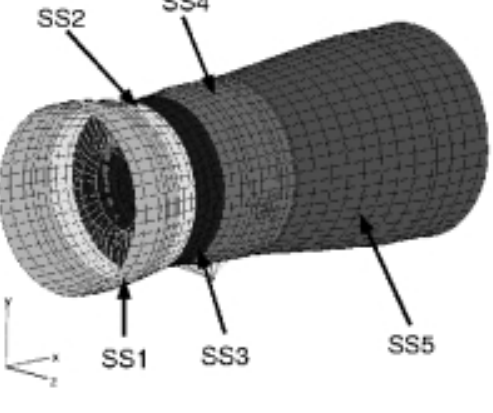
Fig. 1. Aeroengine casing and substructuring